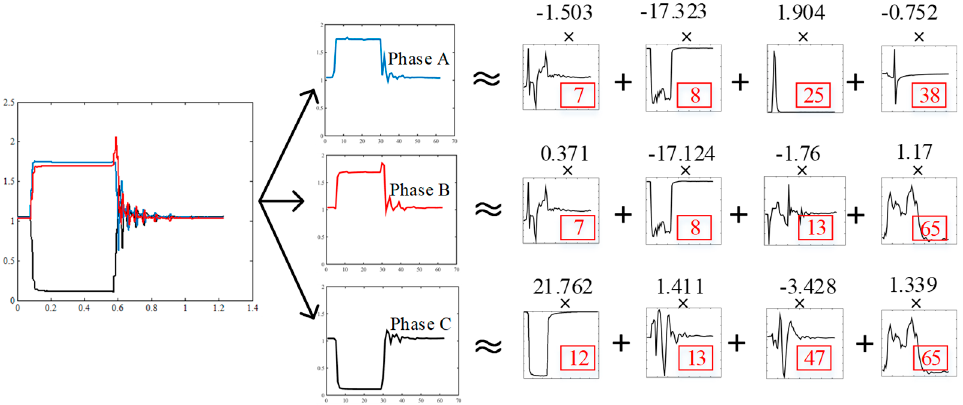
Figure 3. Decomposition diagram calculated by K-SVD.